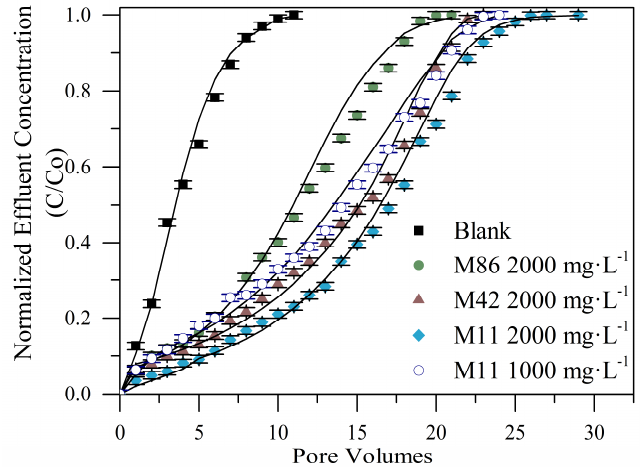
Figure 10. Breakthrough curves for the treatments of three different MgO nanoparticles M11 (at 1000 and 2000 mg · L − 1 ), M42 (at 2000 mg · L − 1 ), and M86 (at 2000 mg · L − 1 ) of the system I in Ottawa 20 / 40 sand packed bed assessed with a kaolinite 0.2% in mass fraction solution at 25 °C.